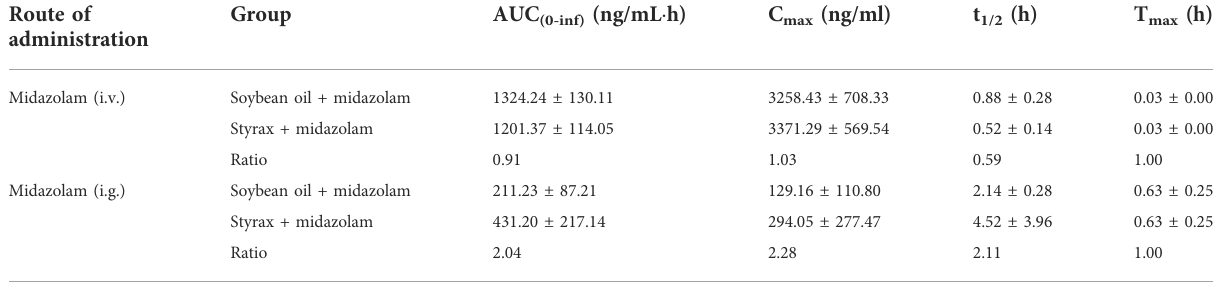
TABLE 1Pharmacokineticparameters of midazolam after administratingmidazolam (i.v., 5 mg/kg; i.g., 20 mg/kg) in rats pretreated with Soybean oil, Styrax (100 mg/kg). Data are the mean ± SD. Route of administration